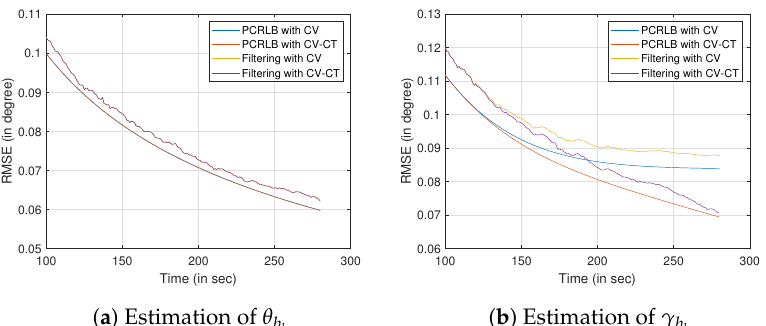
Figure 6. RMSE evaluation for bias estimation using one target of opportunity with known location and terrain